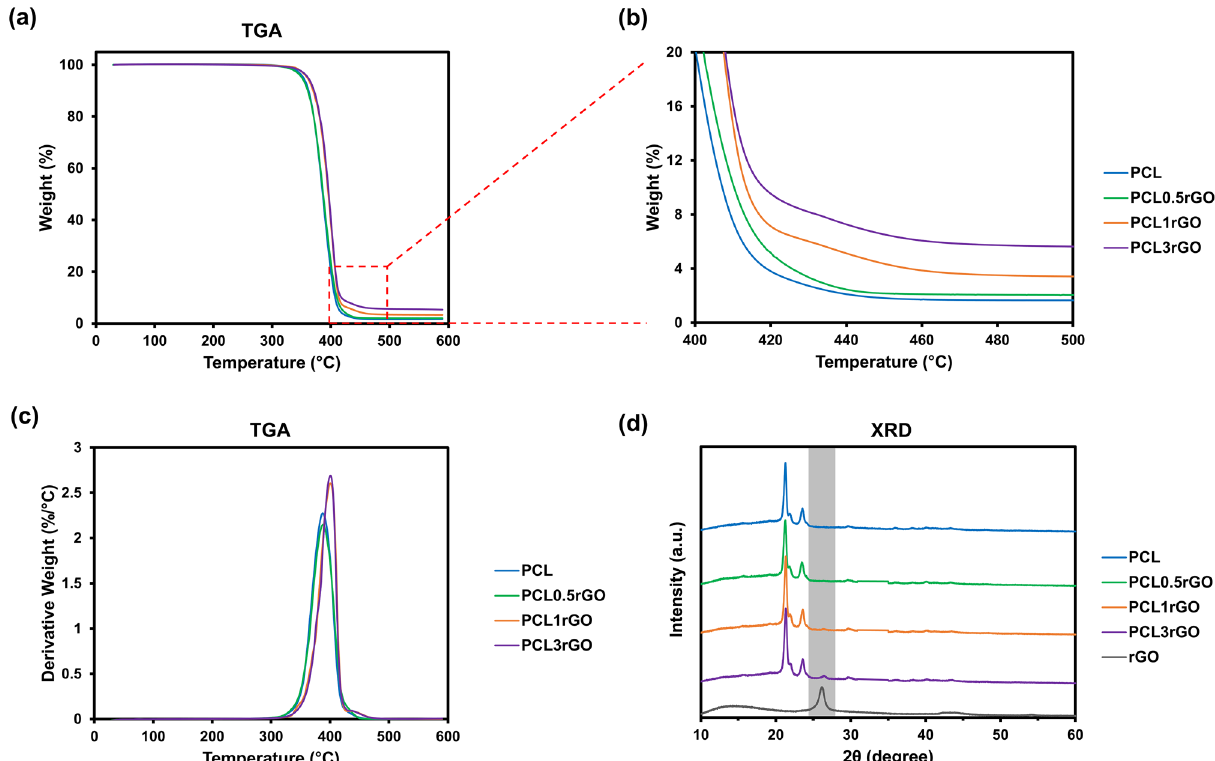
Figure 4. Compositional characterization of the 3D printed scaffolds. ( a ) The TGA thermograms of the 3D printed scaffolds. ( b ) The enlarged region of the TGA thermograms indicating the remaining mass in each sample. ( c ) The TGA first derivative curves of the 3D printed scaffolds. ( d ) The XRD patterns of non-porous 3D printed scaffolds and pure